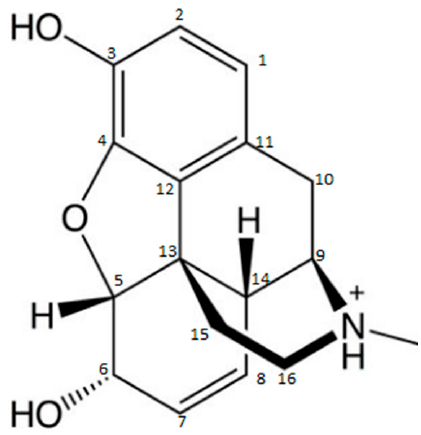
Figure 1. Molecular structure of morphine [36].